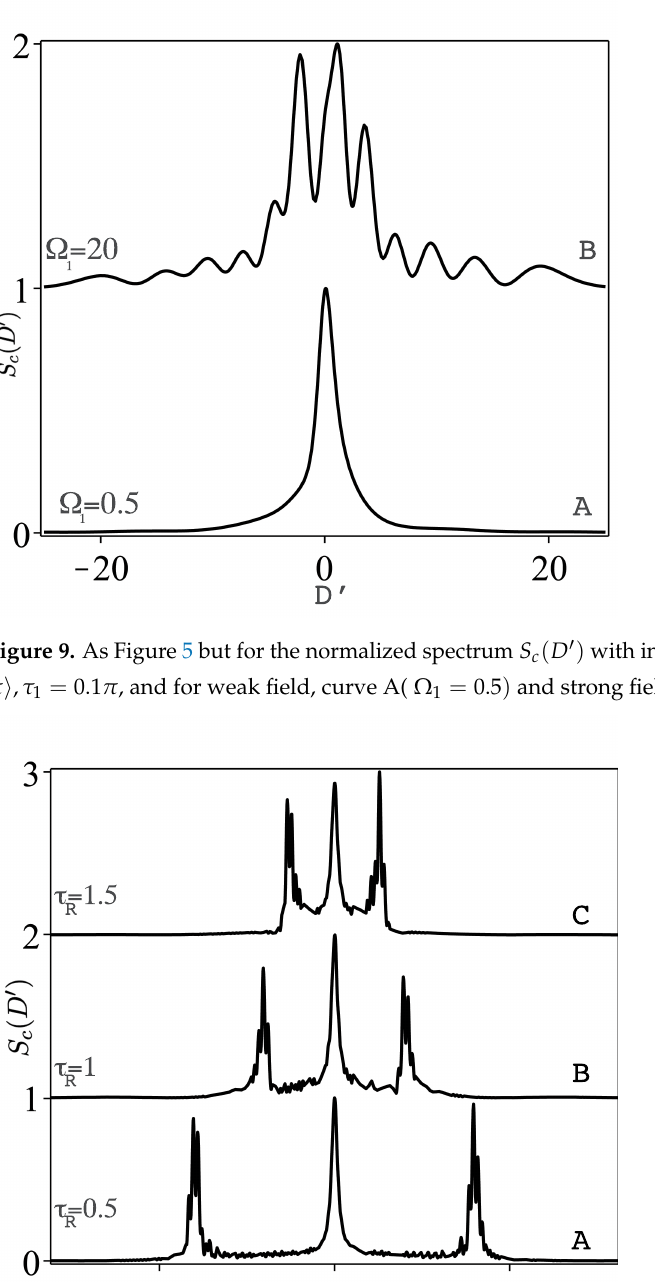
π , φ = π (cid:105) , and strong 2